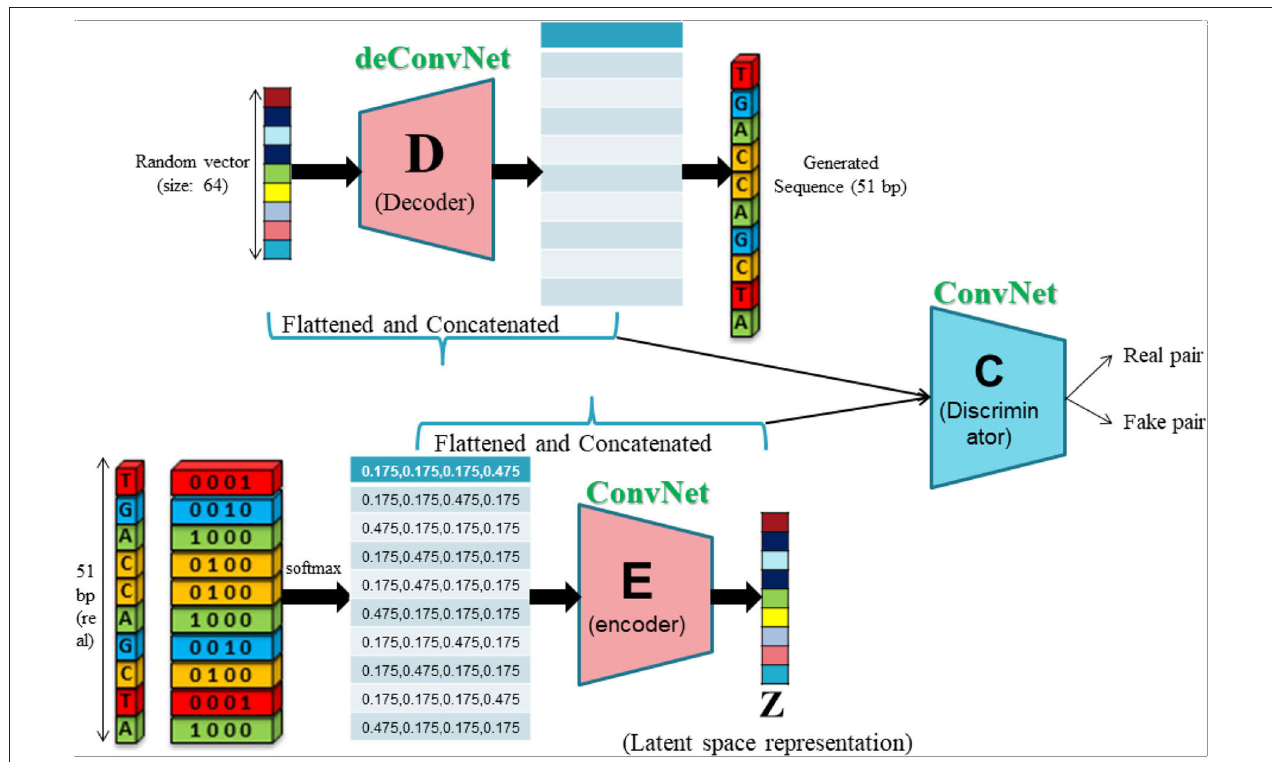
FIGURE 1 | Unsupervised feature learning scheme of